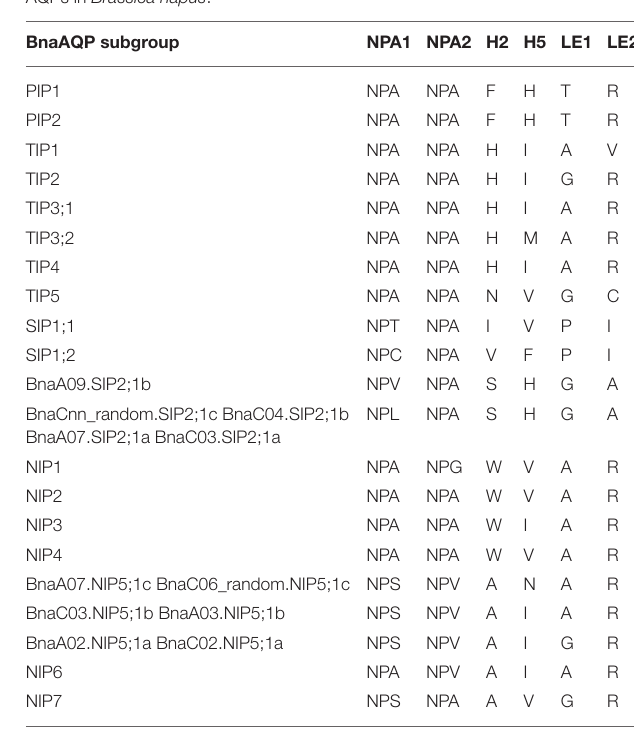
TABLE 3 | Amino acid composition of the NPA motifs and ar/R selectivity filters of AQPs in Brassica napus